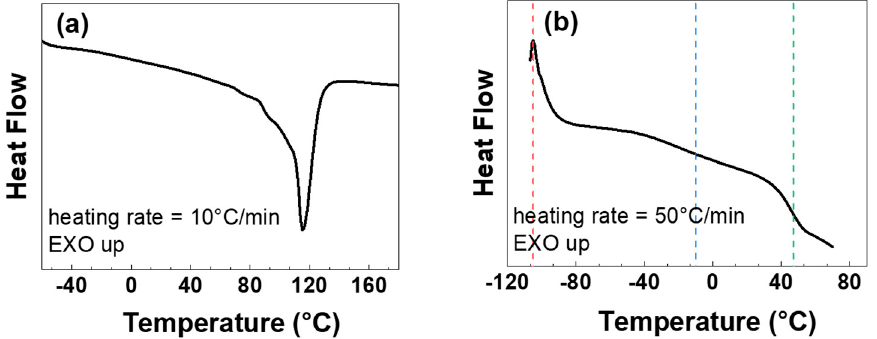
Figure 5. DSC heating curves of a LDPE sample in the –60–180 °C range at the rate of 10 °C/min ( a ) and in the − 110–70 ◦ C range at the rate of 50 ◦ C/min ( b ). Vertical dot lines at T = − 105, − 10 and ( a ) and in the − 110–70 °C range at the rate of 50 °C/min ( b ). Vertical dot lines at T = − 105, − 10 47 ◦ C represent the second-order transition and 47 °C represent the second-order transition temperatures.